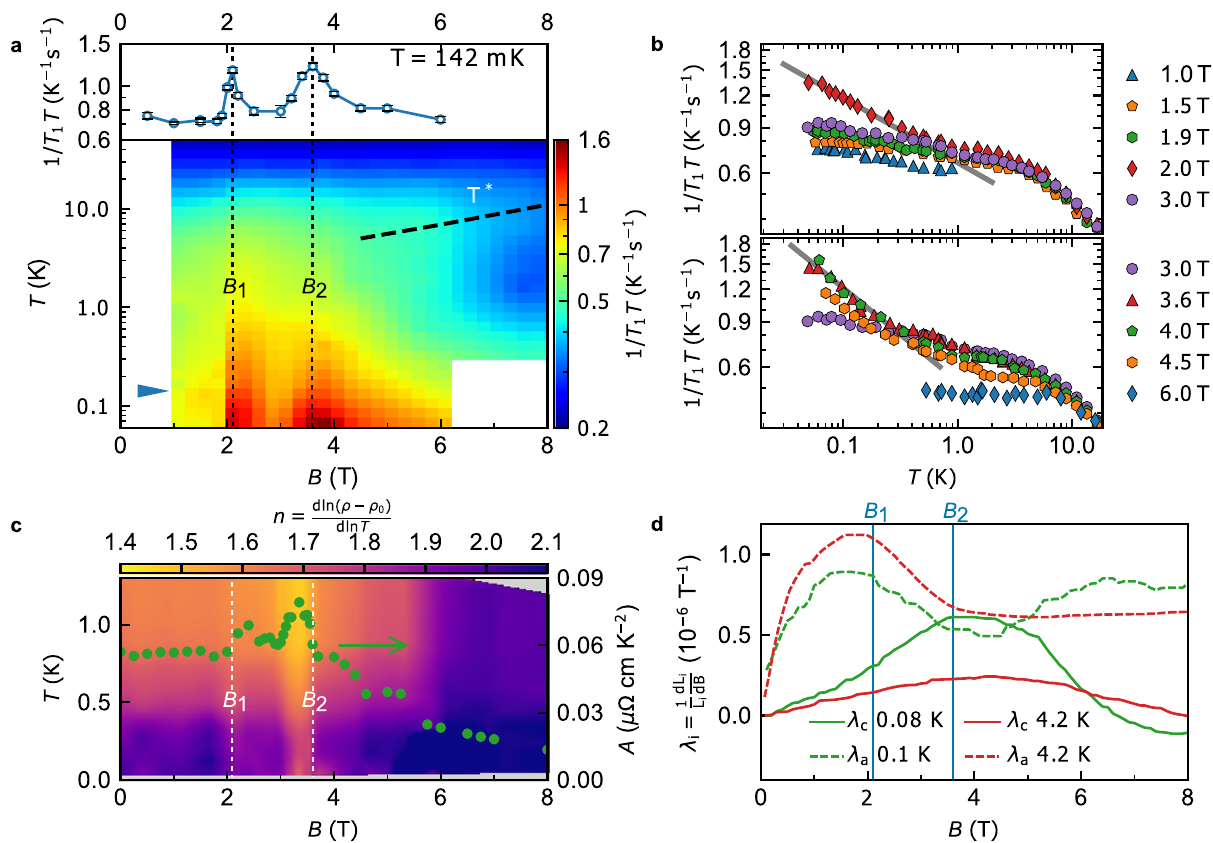
Fig. 2 Detection of quantum criticality by NMR, resistivity and magnetostriction. a (Lower panel) Density plot forming a B − T phase diagram of ð T 1 T Þ (cid:2) 1 on 11 B sites showing the divergent behavior of spin fl uctuations at the two critical fi elds B 1 = 2.1 T and B 2 = 3.6 T. (Upper panel) Cross section of ð T 1 T Þ (cid:2) 1 on 11 B sites at T = 142 mK as indicated by the arrow in the lower panel. Vertical error bars are least-square fi t errors (1 s.d.). b Temperature dependence of ð T T Þ (cid:2) 1 at fi elds close to B B 1 (upper panel) and 2 (lower panel). Error bars are equal or smaller than symbol size, and they correspond to least-square 1 errors (1 s.d.). The lines show a power law dependence of ∝ T − 0.25 (upper panel) and ∝ T − 0.36 (lower panel). The slight mismatch between the ð T values in ( a ) comes from a ~ 1 ∘ deviation in magnetic fi eld orientation with respect to the c axis. c Density plot of the power law exponent of resistivity along the c axis and the A coef fi cient extracted at T = 0.1 K vs B ∥ c . d Magnetostriction coef fi cient λ vs B along both a and c - axes at T = 0.1 K and T = 4.2